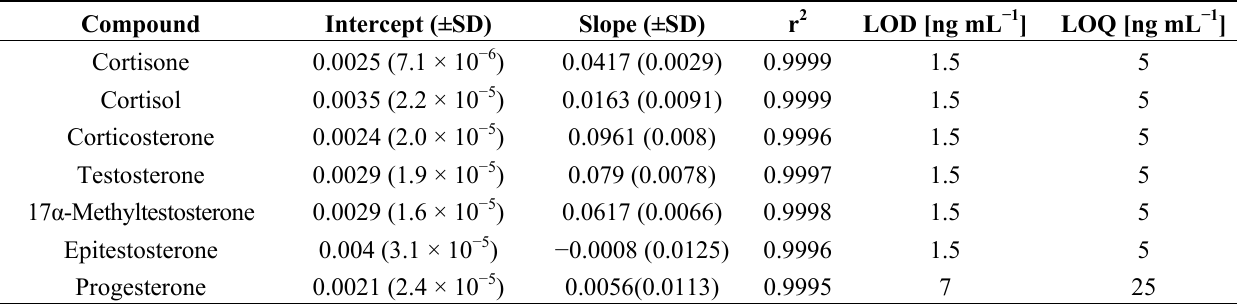
Table 2. Linearity, detection and quantitation limits determined for the proposed MEKC method for steroid